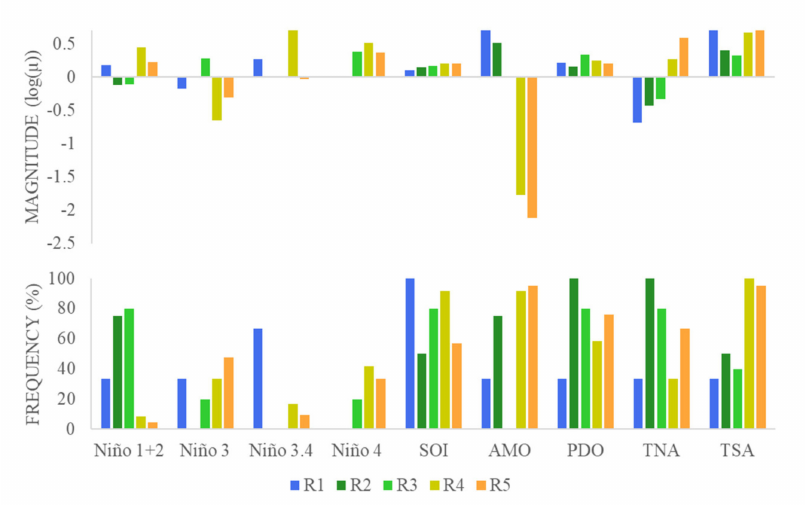
Figure 4. Magnitude of the parameter µ for each of the five homogeneous study regions (R1–R5), associated with the climatic indices and their absolute frequency under S2 at the 5% significance level in the state of Para í